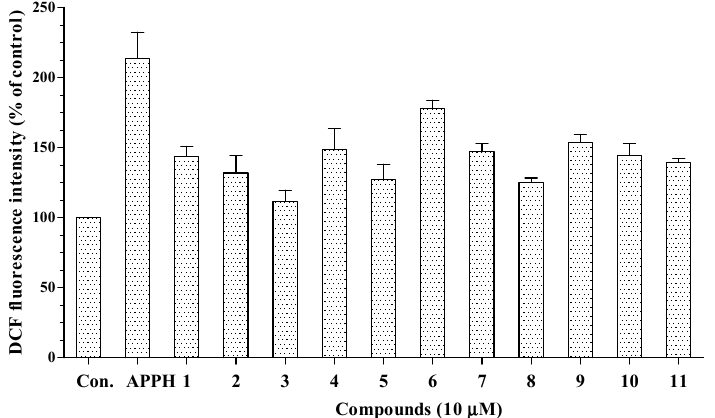
Figure 4. Cellular antioxidant capacity of compounds 1 – 11 against oxidative stress induced by 2,2'-azobisisobutyramidinium chloride (APPH) (Con.: control). Data are expressed as percentages of the value of untreated cells (mean ± standard deviation of three individual experiments). Statistical significance is determined by one-way ANOVA followed by Dunnett’s multiple comparison test ( p < 0.05). The MeOH extract and CHCl 3 fraction also exhibited moderate TRAP activity at 10.0 μ g/mL (Figure 5A). We also investigated the anti-osteoporotic activity of compounds 1 – 11 by evaluating their inhibitory effects on TRAP activity in osteoclasts differentiated from RAW 264.7 cells. Osteoclast